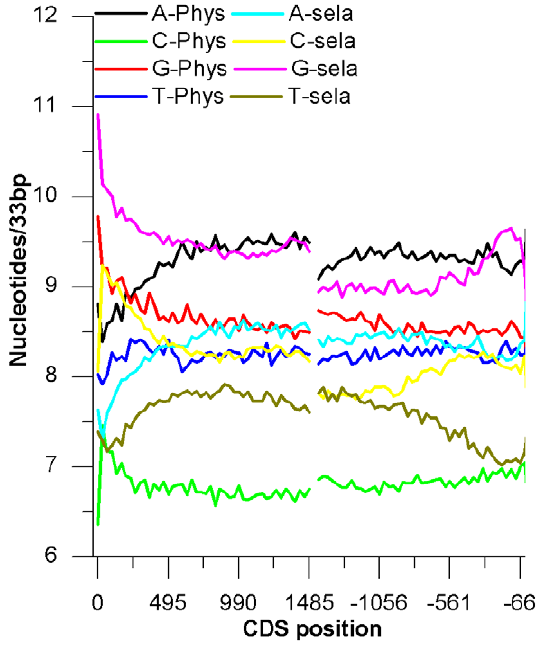
Figure 4. Mononucleotide content of bryophytes CDS. Overall mononucleotides content as function of position in Physcomitrella and Selaginella coding sequences and averaged over all sequences in the dataset with a 33 bp adiacent window.